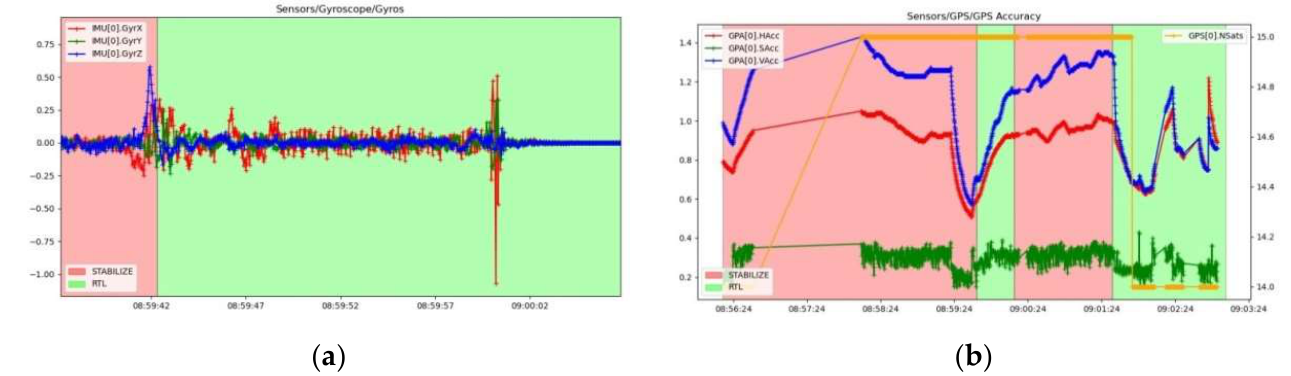
Figure 31. Gyro rotational speeds and accuracy of data received from GPS satellites. ( a ) Gyro rotational speeds in rad/s for IMU (0) and (1); ( b ) Accuracy of data received from GPS satellites.